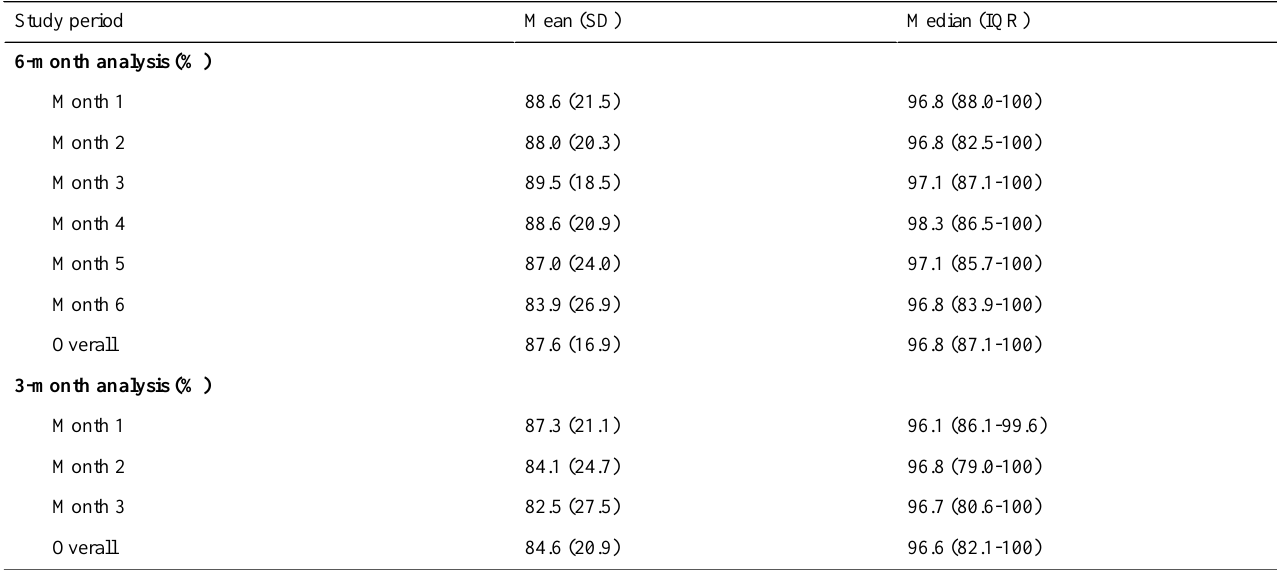
Table 1. The overall median implementation adherence was Table 1. Adherence rates across the 6-month and 3-month time